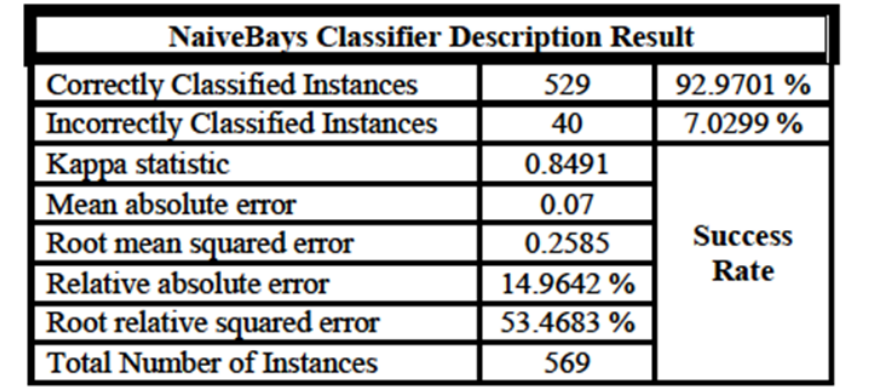
Table 1. Detailed Accuracy by Class for NB